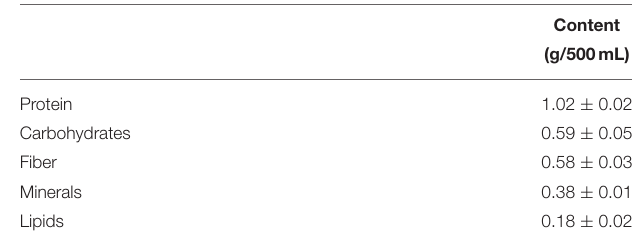
TABLE 1 | Chemical composition of the beverage Chaya. Data are expressed as a portion of daily intake (20 g/500mL). Values represent the mean ±